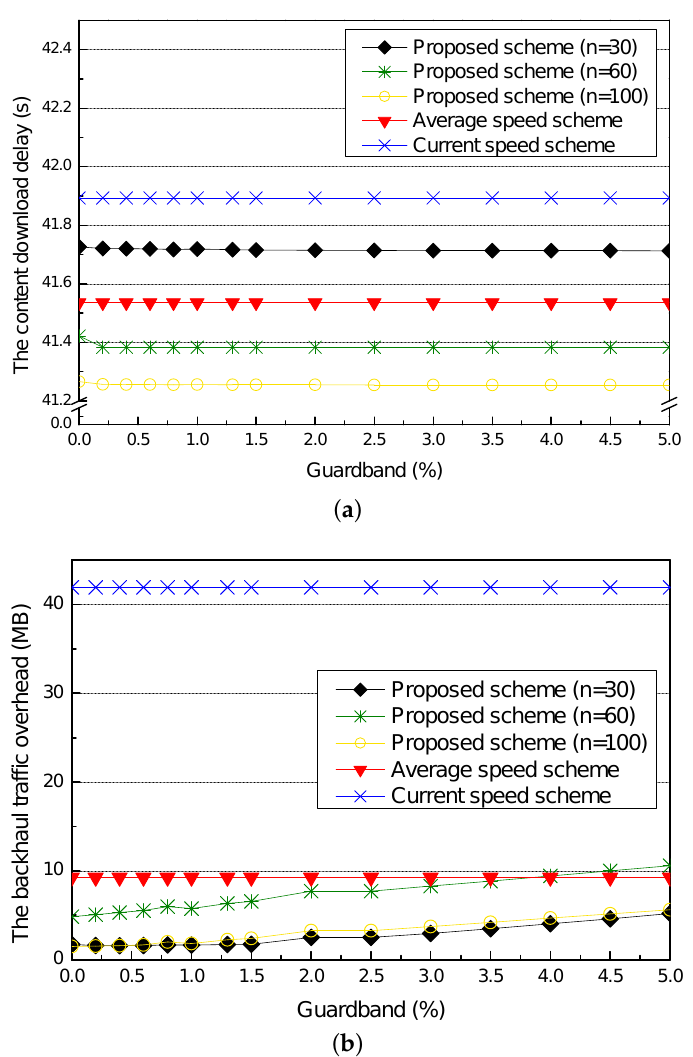
Figure 9. Simulation results for different guardbands: ( a ) the content download delay and ( b ) the backhaul traffic